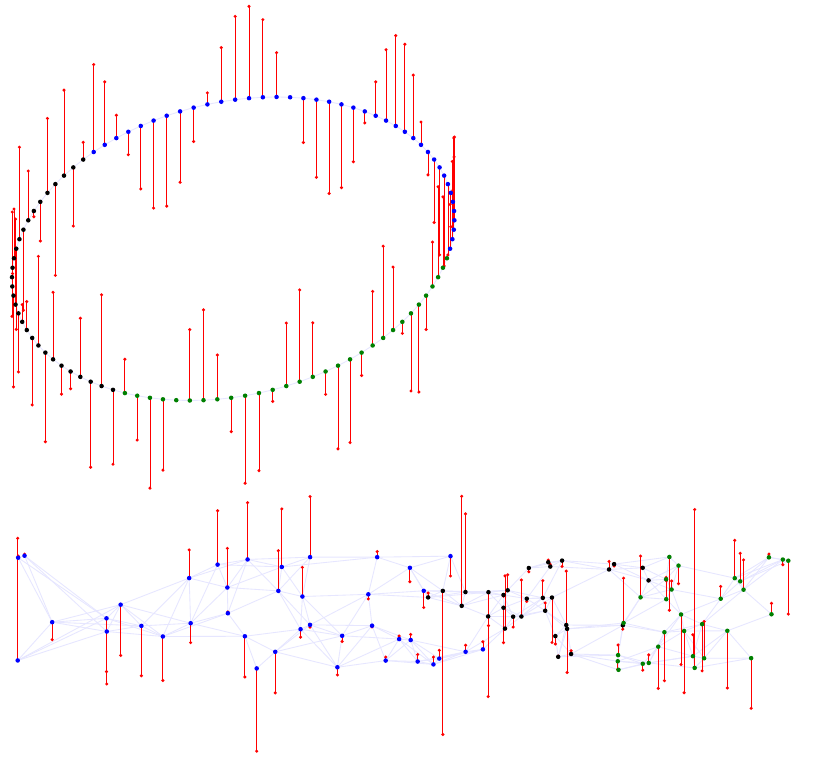
Figure 3. Graph signal on a circular undirected unweighted graph (top), and a general graph (bottom). Vertices from V 1 are designated blue dots, vertices form V 2 are marked by black dots, while vertices form V 3 are given by green